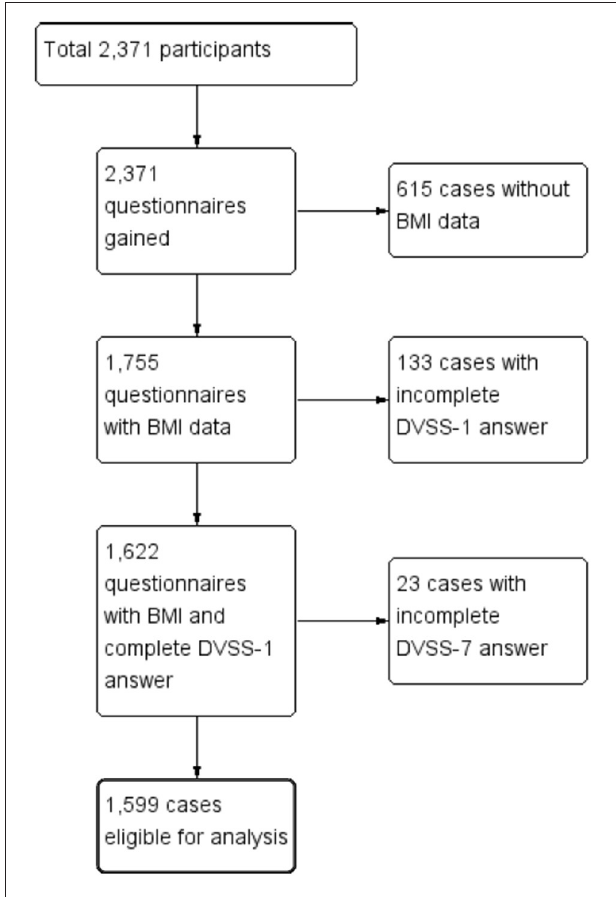
FIGURE 1 | Flow chart of participant